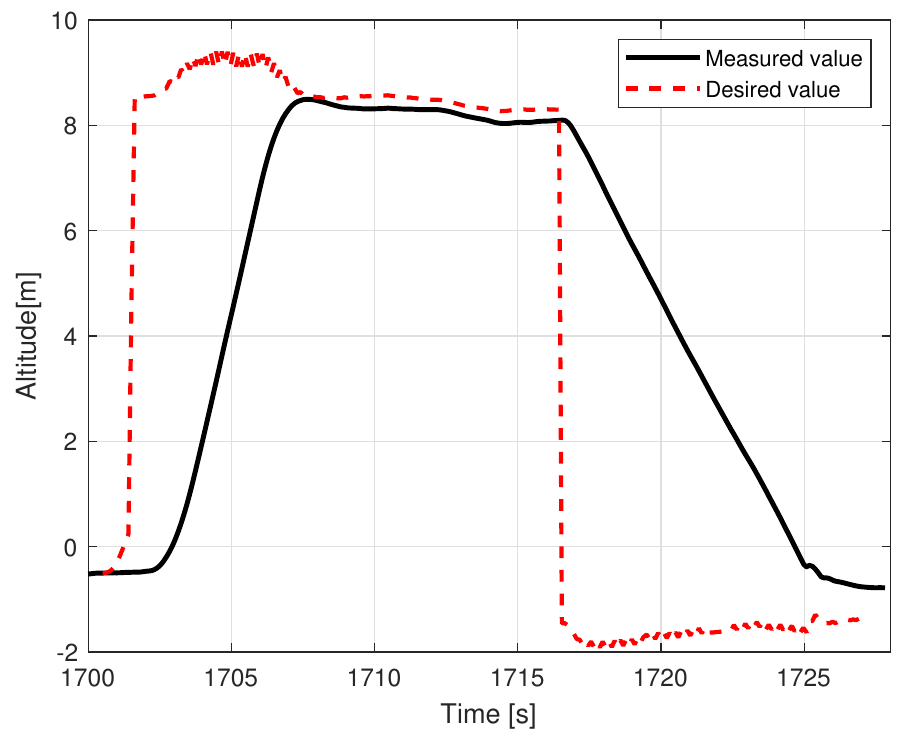
Figure 21. Multicopter altitude during the in-flight test.